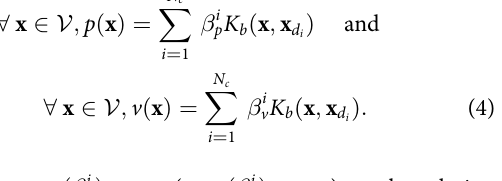
ALGORITHM 1 | Estimation of the general and individual cortical thickness decrease with the MCMC-SAEM algorithm. Input : Longitudinal dataset y = ( y i,j ) i,j of measurement maps, with the corresponding ages ( t i,j ) i,j . Initial parameters θ 0 and latent variables z 0